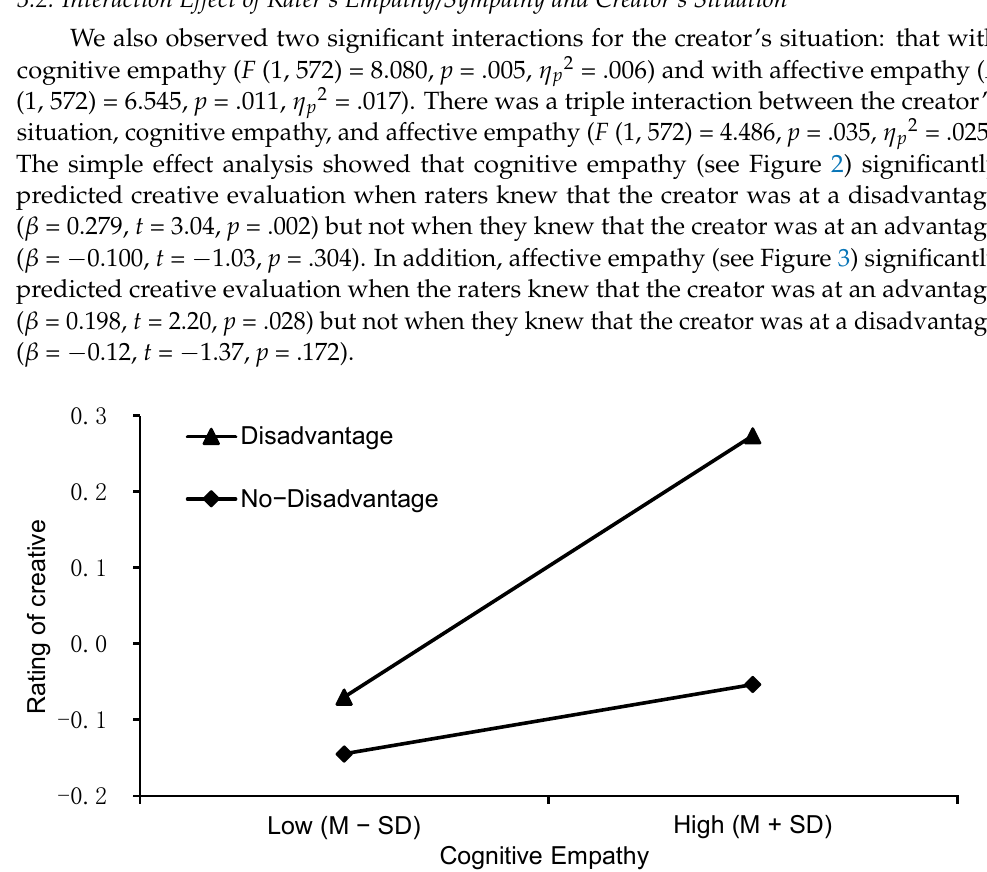
Figure 3. The interaction effect of affective empathy and the creator’s situation on creative evalua- tion. To explore the triple interaction effect of the creator’s situation, cognitive empathy, and affective empathy, two moderation analyses were implemented in the disadvantaged and advantaged conditions. The results showed that, in the disadvantaged condition, the interaction effect of cognitive empathy and affective empathy was significant ( β = −0.265, p = .017). Simple slope analysis showed that the raters’ cognitive empathy significantly predicted their creative evaluation when their affective empathy was high ( β = 0.503, t = 4.928, p < .001) and moderate ( β = 0.357, t = 4.073, p < .001). When their affective empathy was low, this prediction only reached marginal statistical significance ( β = 0.211, t = 1.904, p = .058). See Figure 4. In the advantaged condition, the interaction effect of cognitive empathy and affective empathy was significant ( β = 0.236, p = .003). Simple slope analysis showed that the raters’ affective empathy predicted their creative evaluation when their cognitive empathy was high ( β = 0.352, t = 3.951, p < .001) and moderate ( β = 0.225, t = 2.853, p = .005), but not when it was low ( β = 0.098, t = 1.090, p = .277). See Figure 5.